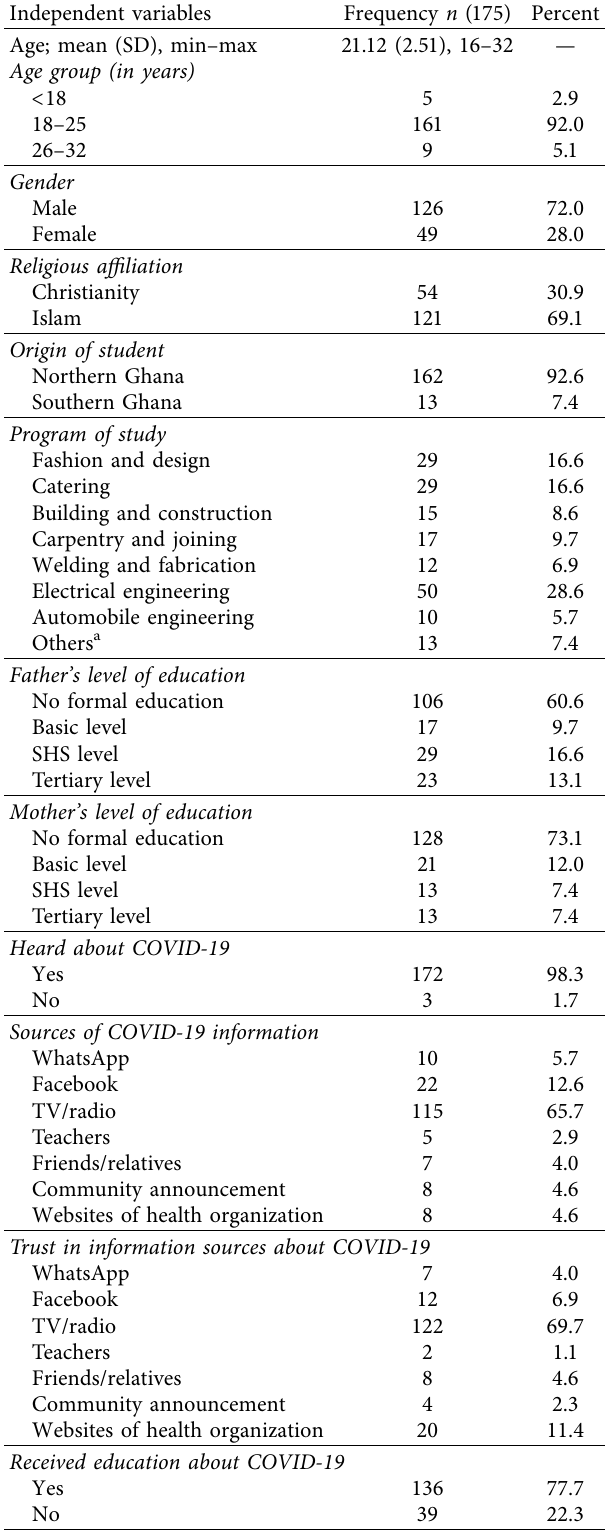
Table 1: Sociodemographic characteristics of the study